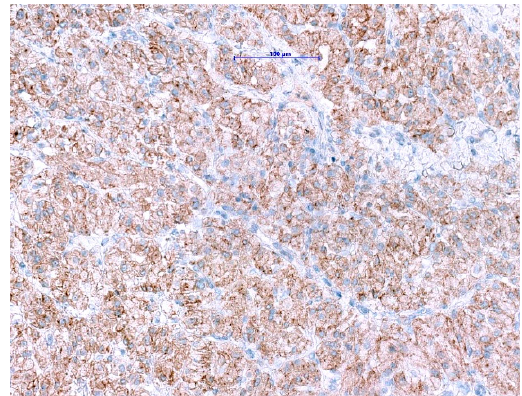
Figure 7. Immunohistochemical staining with pan-TRK antibody in GIST shows diffuse cytoplasmic and membranous expression. (Scale bar shows 0.1 mm).